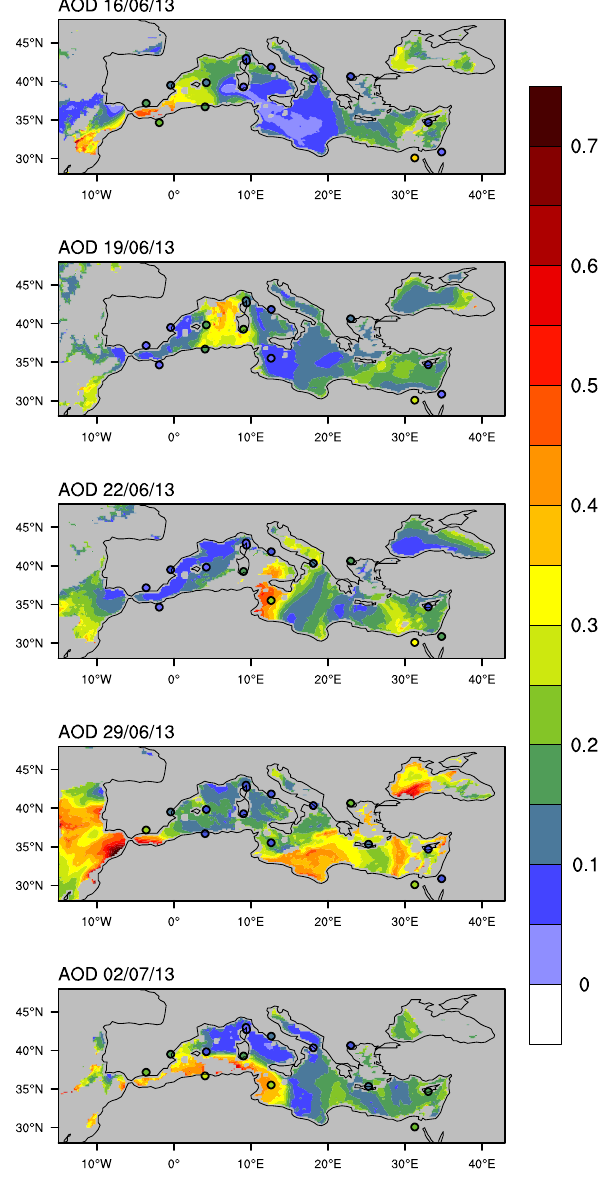
Figure 6. AOD MSG/SEVIRI observations for 5 different days dur- ing the SOP-1a experiment (16, 19, 22, and 29 June and 3 July). The AERONET/PHOTONS AOD is also